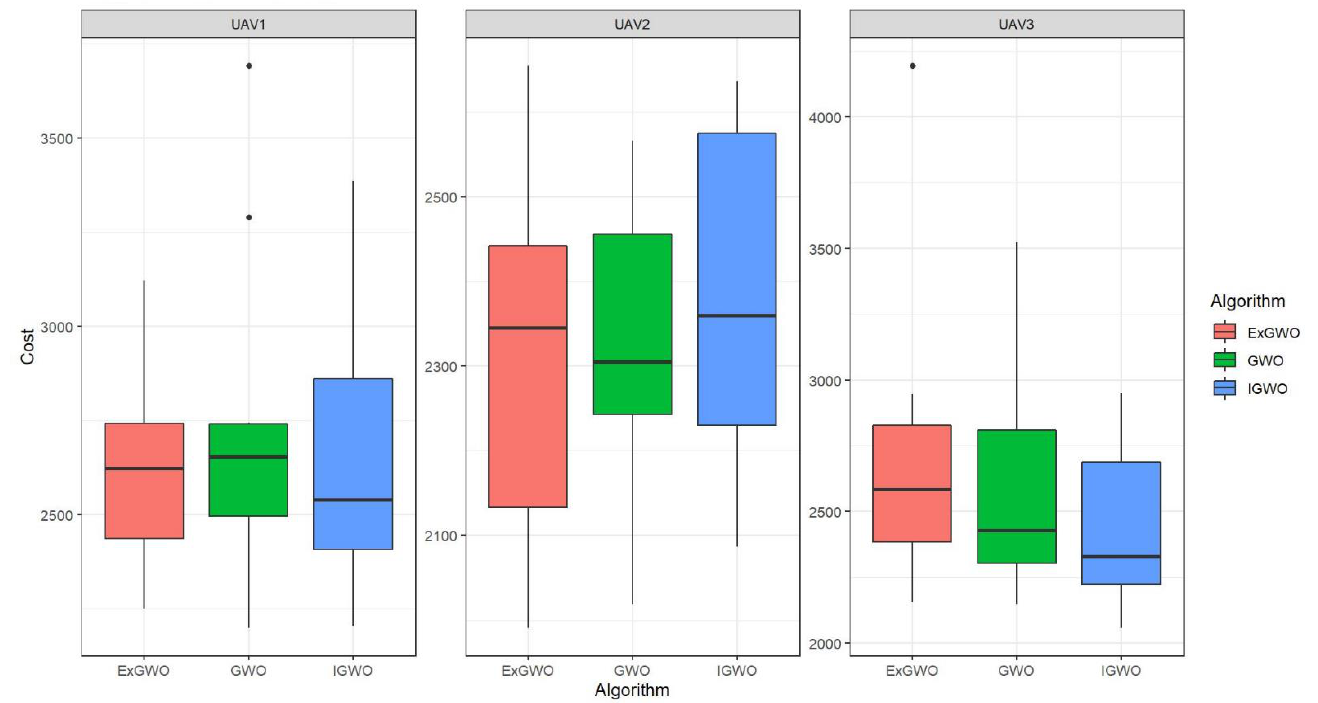
Figure 10. Boxplot graph analysis for each UAV in population of 30 and 50 iterations.